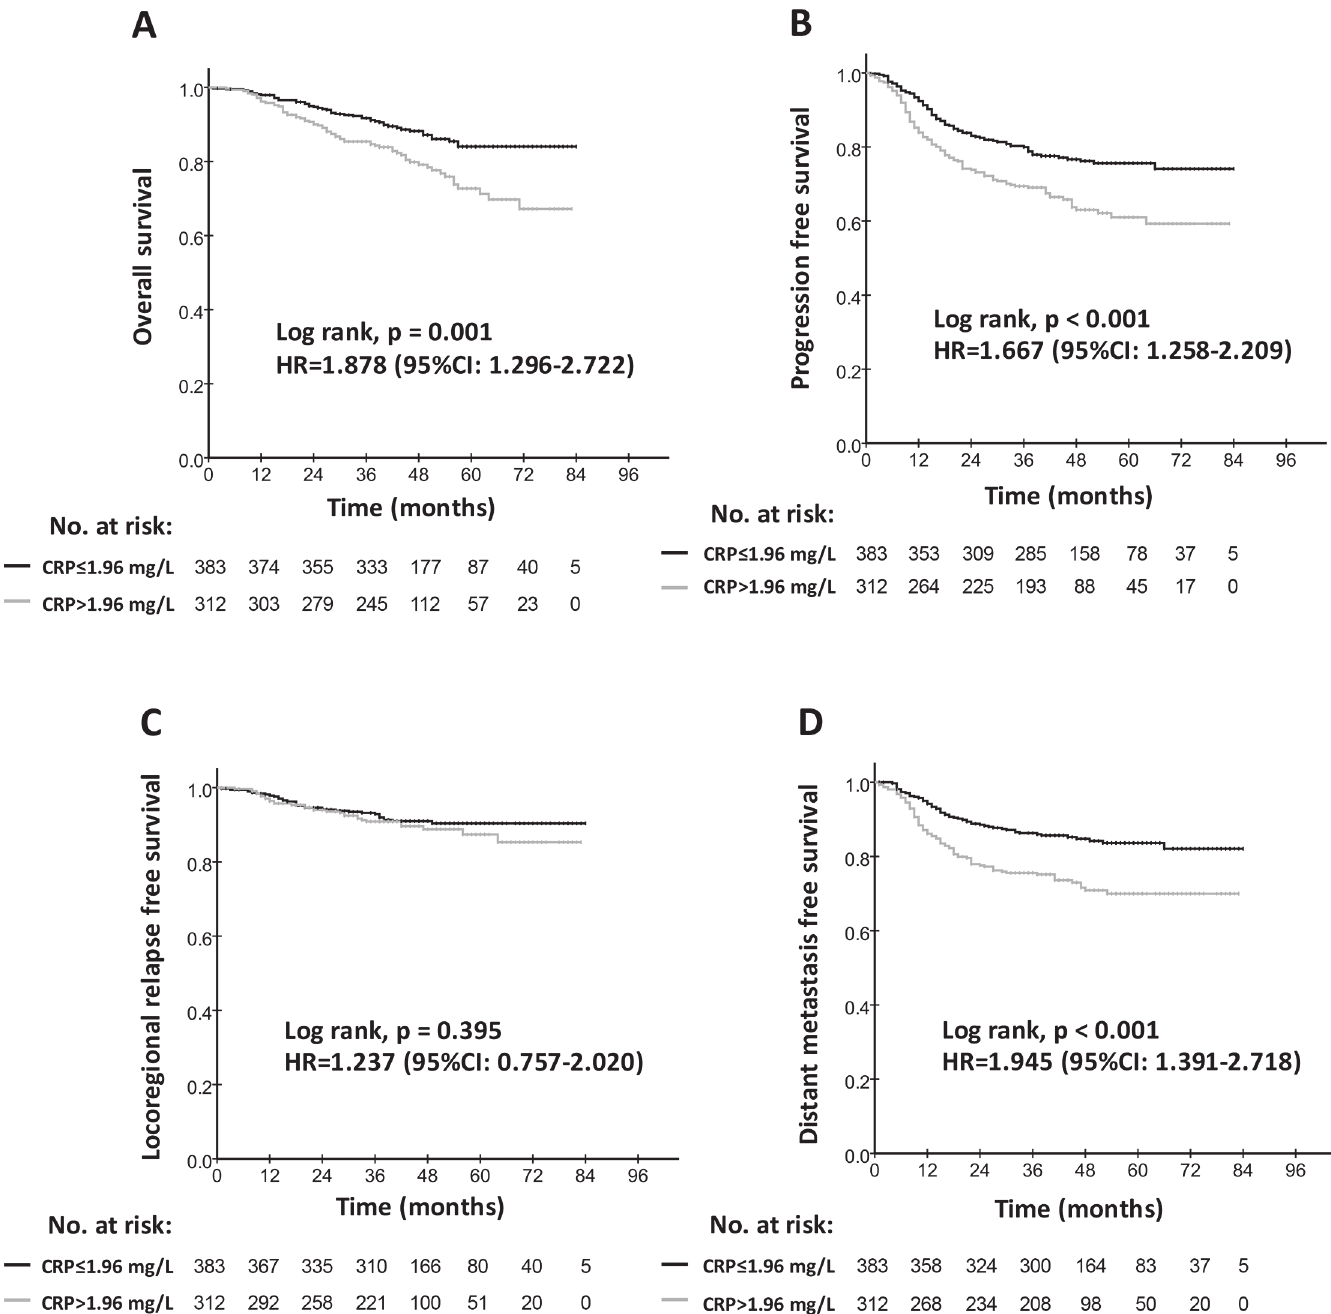
Fig 2. Kaplan-Meier survival curves for the low hs-CRP group ( (cid:3) 1.96 mg/L) and the high hs-CRP group ( > 1.96 mg/L) in patients with high EBV DNA. Overall survival rates (A), progression-free survival rates (B), locoregional relapse-free survival (C) and distant metastasis-free survival rates (D) were compared in the subgroup of NPC patients with EBV DNA > 4000 copies/ml. Hazards ratios (HRs) were calculated using the unadjusted Cox proportional hazards model. P values were calculated using the unadjusted log-rank